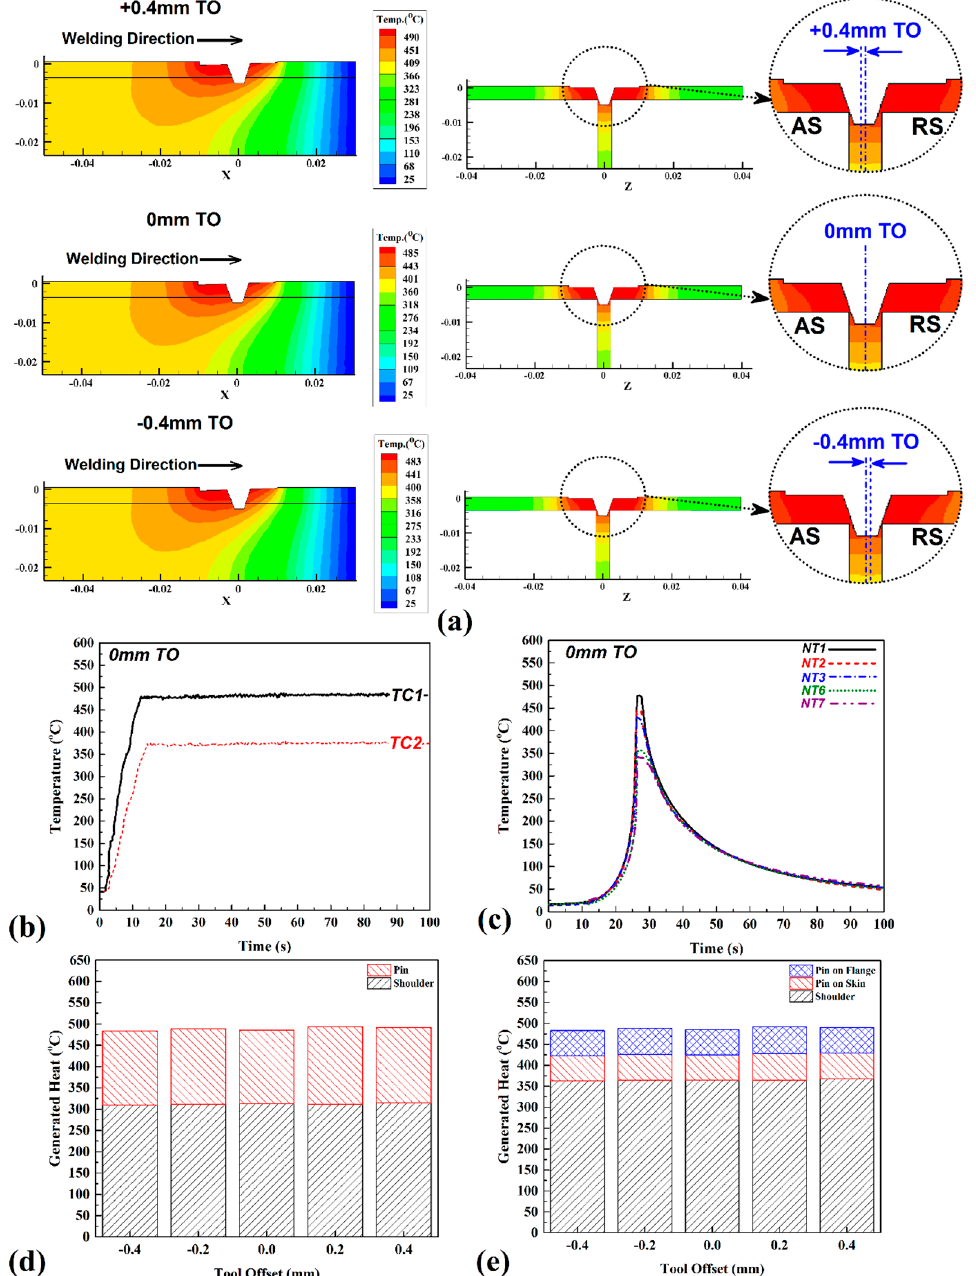
Figure 3. Simulation results of internal heat flow at ( a ) longitudinal and cross section of various TOs. ( b ) Recorded temperature by FSW tool. ( c ) Recorded temperature by thermocouples at surface of skin and flange. ( d ) Recorded temperature by thermocouples insides the FSW tool and ( e ) Simulation results of generated heat at various